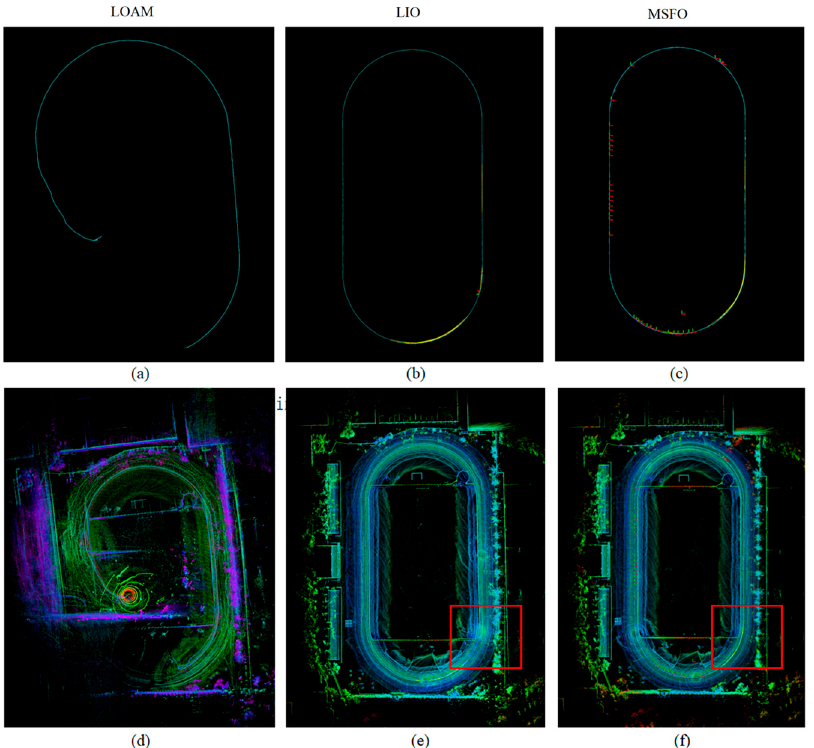
Figure 7. A comparison of LOAM, LIO, and MSFO, respectively, based on the trajectory recovery and mapping reconstruction. The LO trajectory and point cloud reconstruction are very different from the actual situation, and the channel degradation phenomenon occurs, as shown in ( a , d ). When the LIO returns to the origin, the accumulated error leads to the point cloud separation, as shown in ( b , e ). After fusing GNSS factors, the positioning accuracy of MSFO is effectively improved and there is no obvious separation of point clouds, as shown in ( c , f ).